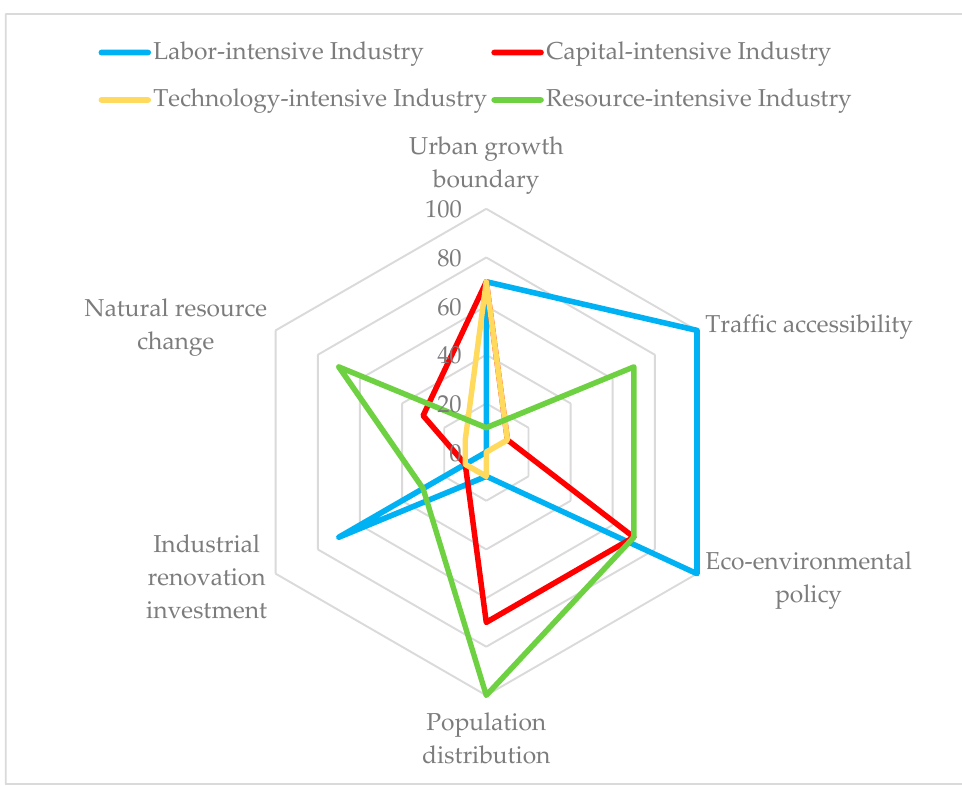
Figure 35. Comprehensive influence mechanism of the six factors on the operation state of Nanjing industrial heritage sites (Figure source: own drawing).